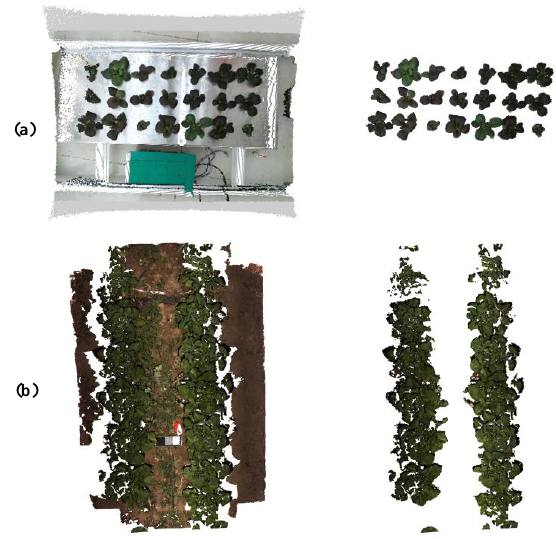
Figure 8. The removal of natural background results in new experimental data. ( a ) the first row of data were acquired by our platform in the greenhouse, ( b ) the data of second row were published by Mortensen et al. [26] and acquired by stereo-configuration. The ground truth was segmented manually. The accuracies calculated by Equation 2 were 98.21% and 92.53%, respectively.